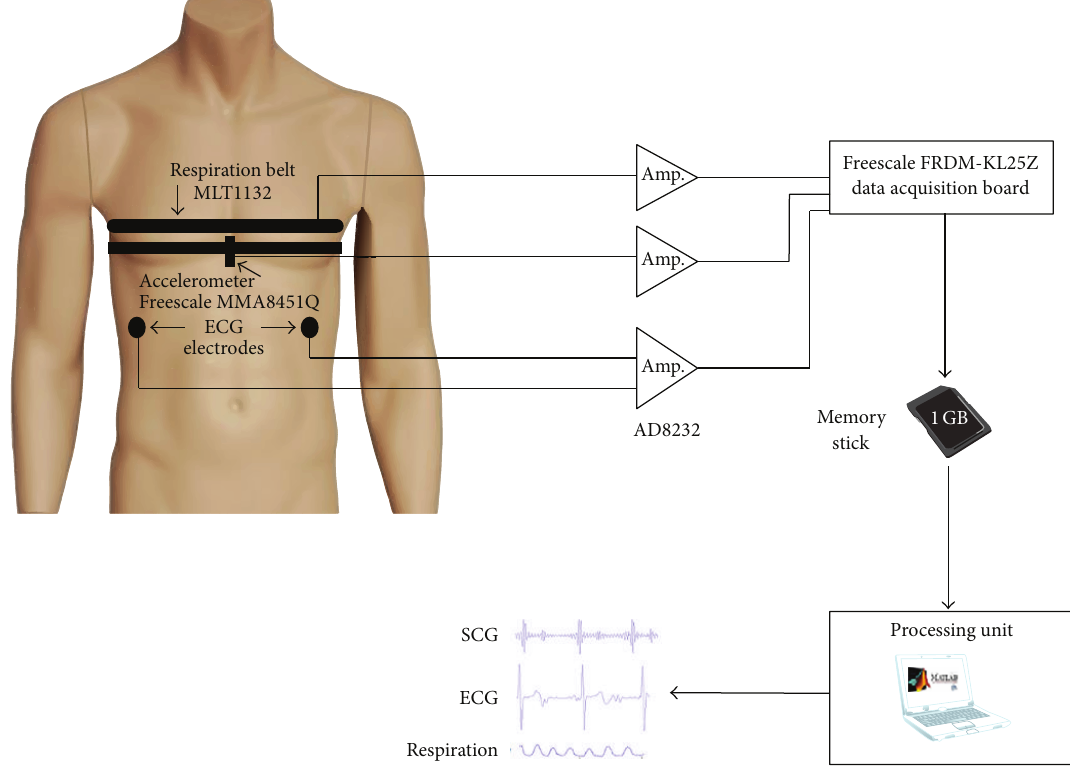
Figure 2: Block diagram of measurement setup. The ECG electrodes, accelerometer, and respiration belt were connected to the main measuring unit. After that, the collected data were transferred to the processing unit which was a personal computer.